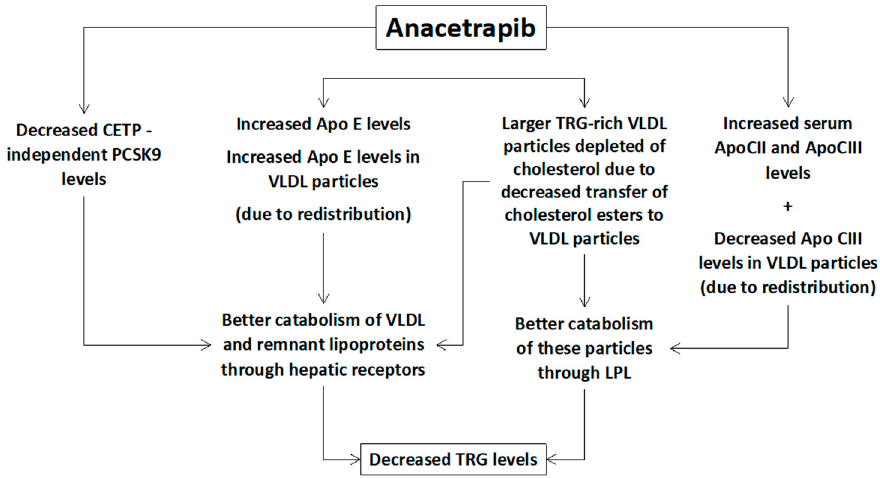
Figure 2. Potential mechanisms of the anacetrapib-mediated reduction of triglycerides (TRG). PCSK9: